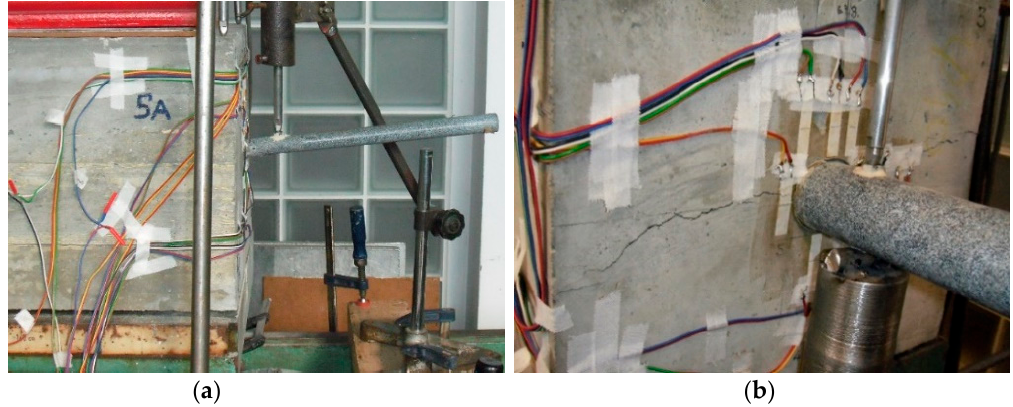
Figure 11. Damage of testing beam: ( a ) No.1—dowel Ø 20 mm; ( b ) No.4—dowel Ø 40 mm.